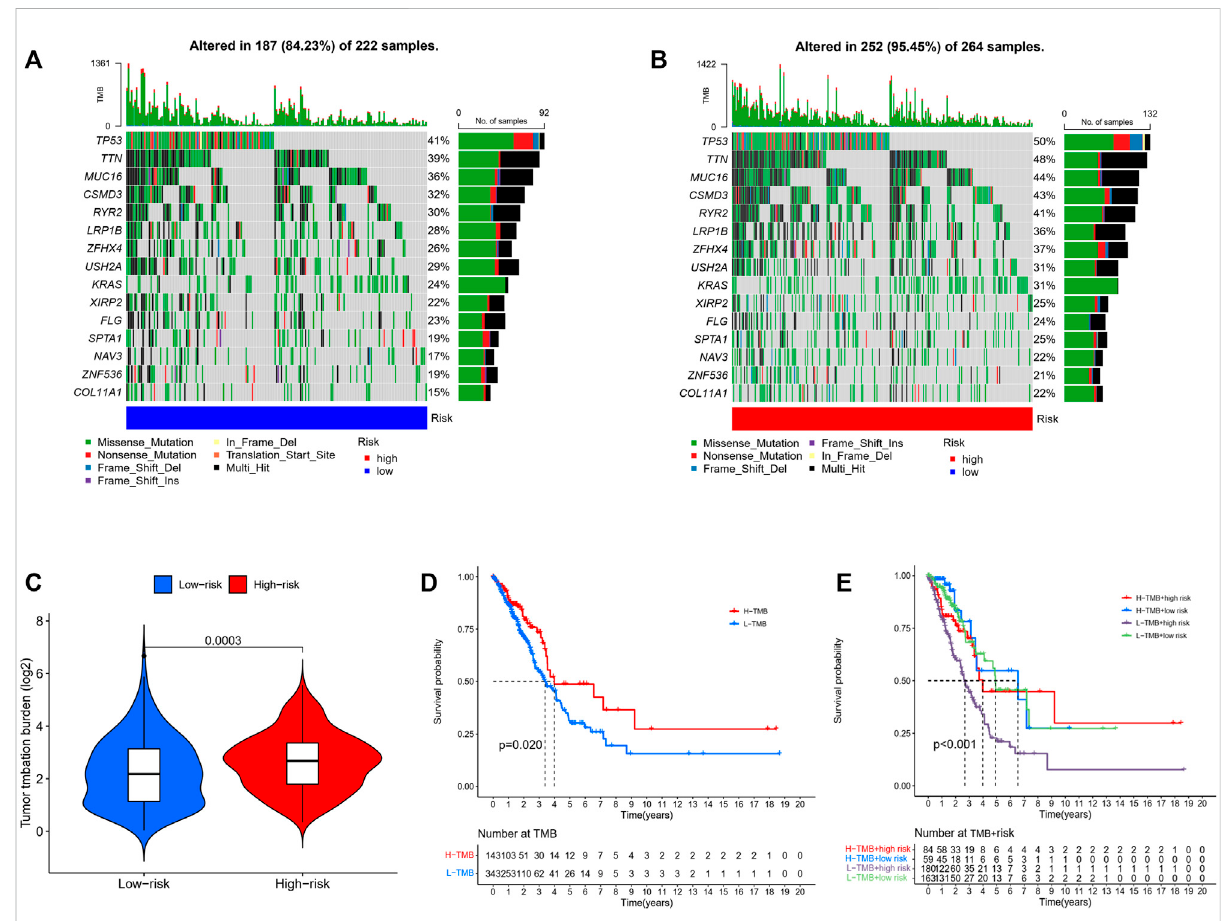
FIGURE 7 (A,B) Mutationsin common genes betweenlow- and high-risk groups. (C) Comparison ofthe tumor mutation burden betweenlow- and high- riskgroups.(Wilcoxon test) (D) Comparisonofthesurvivalprobability withdifferentlevels oftumormutationburden. (E) The survivalprobability with different levels of tumor mutation burden and risk score. (Chi-squared